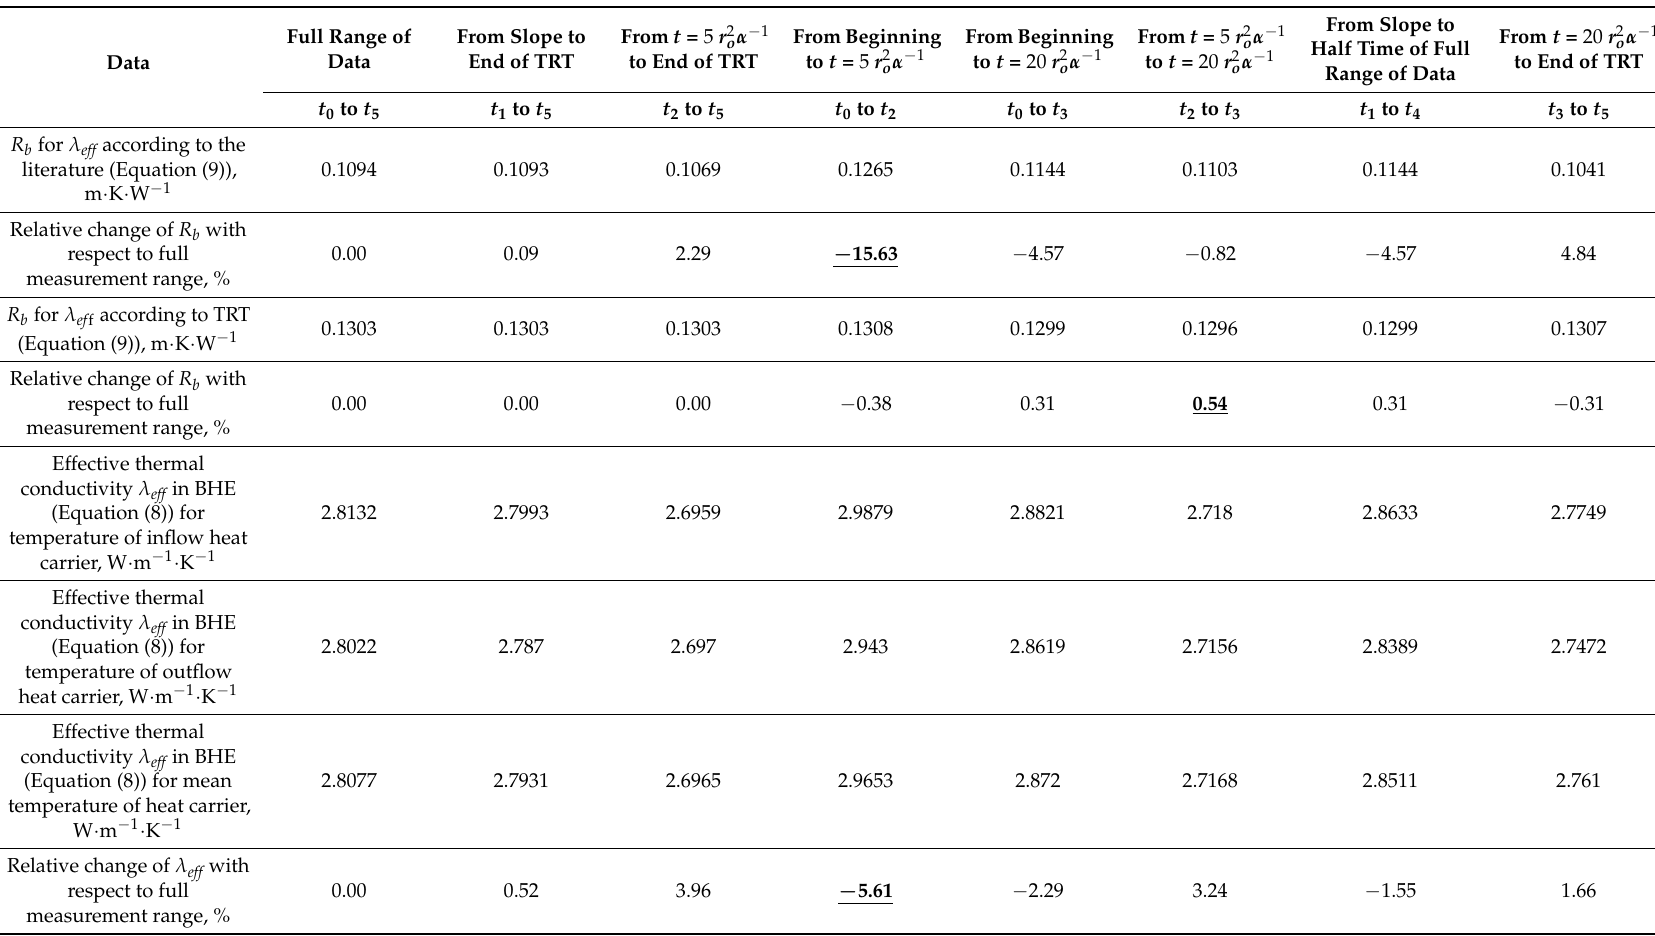
Table 4. Thermal resistivity R b and effective thermal conductivity λ eff of BHE, as determined for various data ranges (TRT in ˙Zar ó